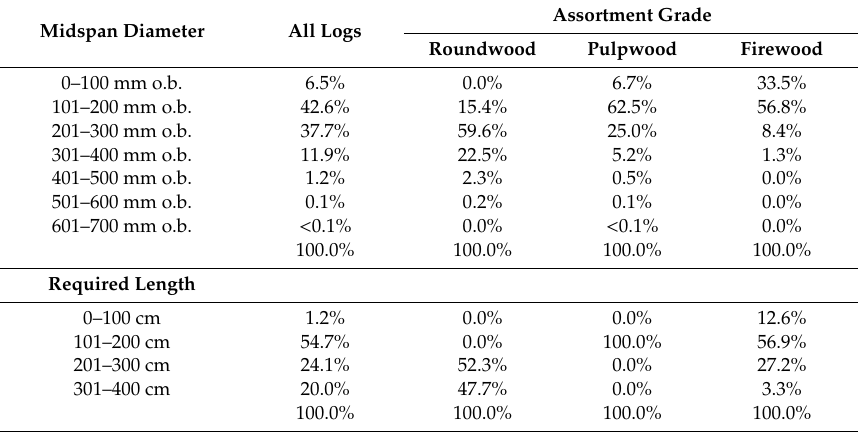
Table 1. The relative distribution of required lengths and midspan diameters of logs. Midspan Diameter All Logs Assortment Grade Midspan Diameter All Logs Roundwood